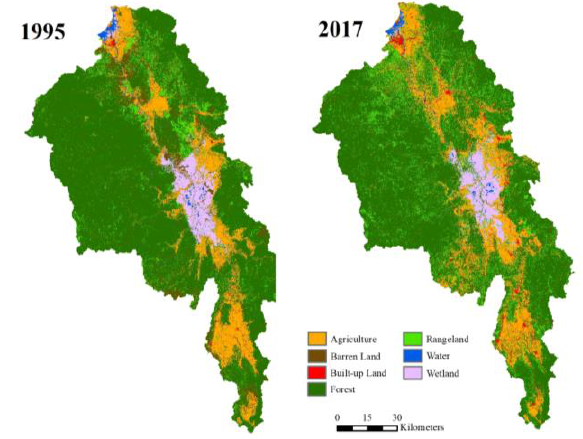
Figure 2. Level 1 land cover classifications of the ARB for 1995 and